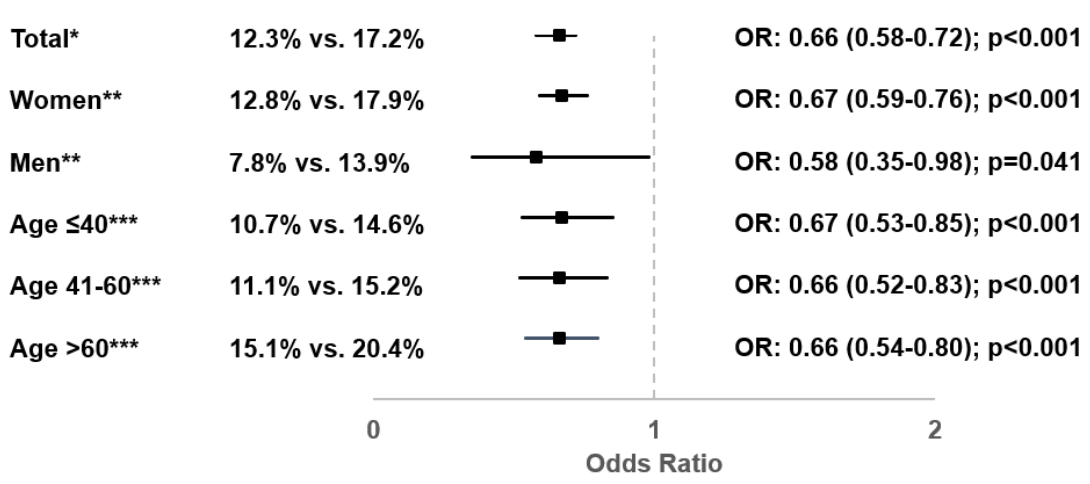
Figure 2. Association between Canephron ® prescription and renewed sporadic confirmed diagnosis of UTI within 30–365 days after the index date (Canephron ® versus antibiotic). * Multivariable logistic regression adjusted for age, sex, health insurance coverage, practice specialty, and CCI. ** Multivariable logistic regression adjusted for age, health insurance coverage, practice specialty, and CCI. *** Multivariable logistic regression adjusted for sex, health insurance coverage, practice specialty, and CCI.